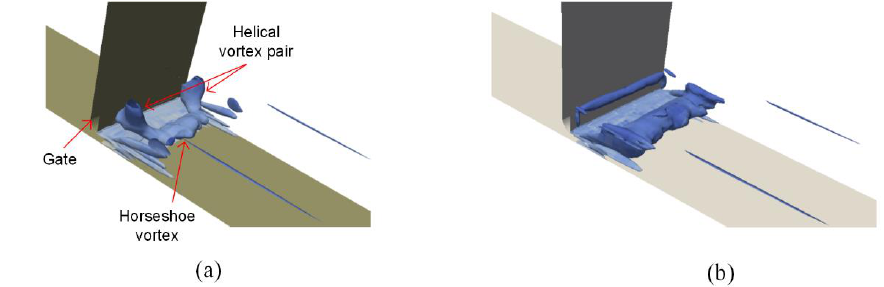
Figure 10. Visualization of vortex structures downstream of the submerged gate flow using the Q - criteria: (a) no baffle; (b) with horizontal porous baffle for 𝜀 = 0.3 and 𝐿/𝐿 𝑟𝑠𝑗 = 0.31 .